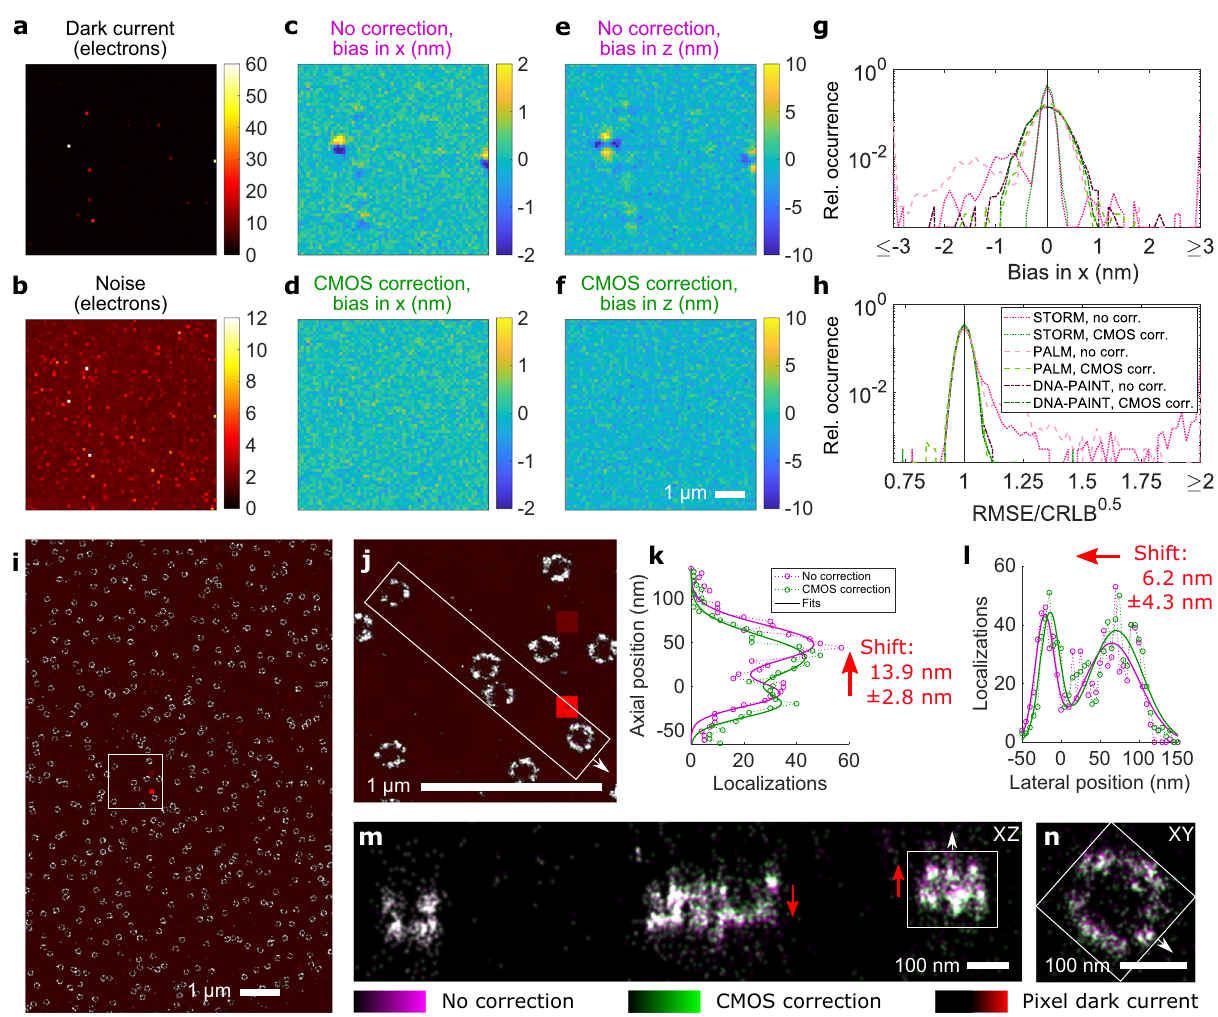
Fig. 2 Camera calibration for thermal effects circumvents systematic fi tting errors in SMLM. Maps of dark current ( a ) and noise ( b ) at 500 ms single frame exposure time for a scienti fi c-grade CMOS (sCMOS) camera cooled to the manufacturer ’ s calibration setpoint of − 10 °C. Simulations of 3D DNA- PAINT via astigmatism-based PSF shaping using this camera reveal a particular pattern in the localization bias close to pixels of high dark current, both laterally ( c ) and axially ( e ) when not applying (s)CMOS-speci fi c fi tting that corrects for pixel-wise effects including thermal effects. Explicit application of (s)CMOS speci fi c fi tting largely removes the bias for DNA-PAINT ( d , f ) as well as STORM and PALM ( g ) and restores the theoretically achievable root mean square error in the localizations ( h ). i , Experimental 3D DNA-PAINT data of the nucleoporin Nup96 in U2OS cells using the same cooled sCMOS camera. The image is rendered as an overlay of the pixel dark current map (red) and the SMLM reconstruction with no camera correction (magenta) and with CMOS correction (green). j , Zoom into boxed region in i . k , l , The structure of a nuclear pore complex (indicated by the boxes in ( m ), ( n )) becomes shifted in the vicinity of a pixel of high dark current, both in axial ( k ) and lateral ( l ) direction when neglecting individual pixel characteristics including thermal effects in the fi tting pipeline. m Axial view of the region indicated in ( j ), also shown in Supplementary Video 1 . n Lateral close up of the nuclear pore complex indicated in ( m ). As expected from the simulation, the shift features a high spatial dependence ( m , n ), which even changes its sign (indicated by the red arrows in n determine the baseline from the y-intersect and the dark current per time from in case of uncooled cameras. We acquired around 8,000 to 20,000 sets of typically 5 the slope, (ii) the variance (i.e. the standard deviation squared) as a function of to 10 different exposure times. To maintain a constant average detector tem- the exposure time to determine the read noise squared from the y-intersect and perature, recording was performed in a nested manner, i.e. we changed the the thermal noise squared per time from the slope, and (iii) the variance as a exposure time after each camera frame and then repeated acquisition of all function of the mean value to determine the gain ( i.e . the conversion factor from exposure times. electrons to ADU counts) from the slope. For each pixel, the exposure time Initially, we used custom-written scripts in Micro-Manager, Fiji and dependent offset was calculated as the baseline plus the dark current per time MATLAB (Mathworks) for data acquisition and analysis, but later implemented multiplied by the single frame exposure time. For each pixel, the exposure time the entire work fl ow into independent Micro-Manager and Fiji ACCeNT plugins dependent noise squared was calculated as the read noise squared plus the (see next paragraph). After recording of raw data as described in the former thermal noise squared per time multiplied by the single frame exposure time. For paragraph, Fiji was used to process the TIFF stacks. For each exposure time and each pixel, the photon response was calculated as the median of the gain map for pixel, the mean value and standard deviation were calculated and saved as TIFF fi les: One after another, the stack corresponding to one exposure time was all pixels multiplied by the pixel-wise value of the fl at fi eld map. To fi nd the fl at fi eld map, we exposed the camera to a homogeneous illumination via ambient imported to Fiji and the “ z-project ” function was called with projection type “ Average Intensity ” for the mean value or projection type “ Standard Deviation ” light and applied the algorithm presented by Lin et al. 5 . for the standard deviation. The resulting TIFF fi les were imported into MATLAB We implemented the photon-free calibration work fl ow including the automated for further processing. For each pixel linear functions were fi tted using the nested data acquisition, fi tting of individual pixel properties and calculation of poly fi t function to (i) the mean value as a function of the exposure time to exposure time dependent camera maps as the ACCeNT plugin for Micro-Manager 2.